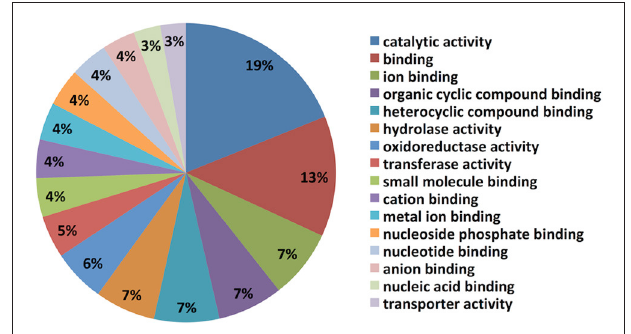
FIGURE 2 | Gene ontology classification results of Trinity assembled C. rosea AMC941 unigenes . Molecular level classification of Trinity assembled unigene GO terms. The percentages represent the ratio of major GO terms assigned to our